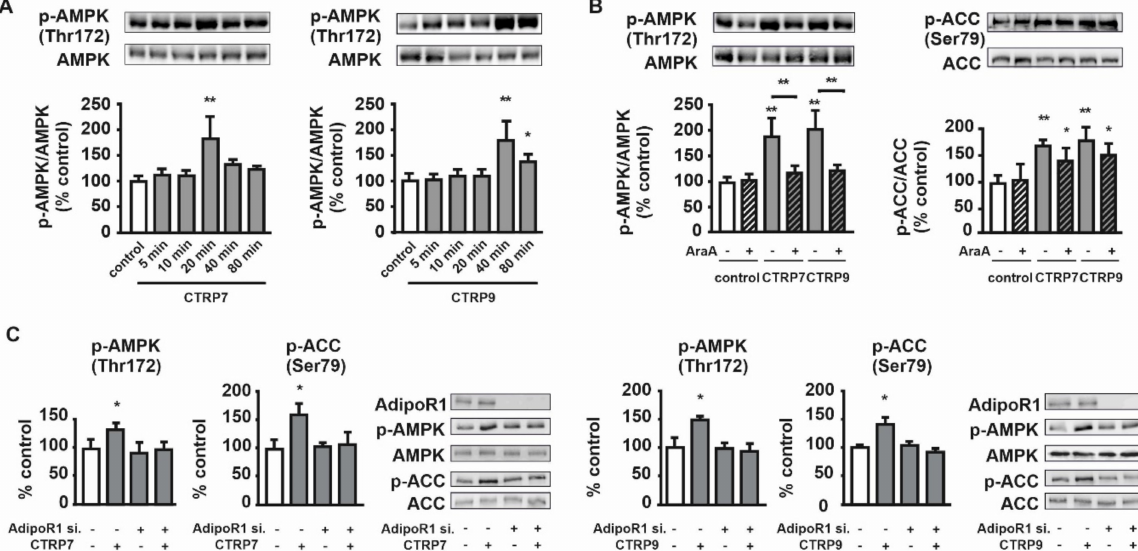
Figure 7. Effects of CTRP7 and CTRP9 on phosphorylation of AMPK and ACC in H9C2 cardiomyoblasts. ( A ) Western Blot analysis showing the time course of AMPK phosphorylation in response to CTRP7 or CTRP9. ( B ) Cells were incubated in the absence or presence of AMPK inhibitor AraA (500 µ M) for 30 min, followed by treatment with CTRP7 for 20 min or CTRP9 for 40 min. Phosphorylation of AMPK and ACC was analyzed by Western Blot. ( C ) Western blot analysis showing phosphorylation of AMPK and ACC in mock or AdipoR1 siRNA transfected H9C2 cells, treated with CTRP7 or CTRP9, as described above. Total AMPK or total ACC served as loading control ( A – C ). Data are mean ± SEM from 5 independent experiments with 3 biological replicates, each. * p < 0.05, ** p < 0.01 vs. control, unless otherwise